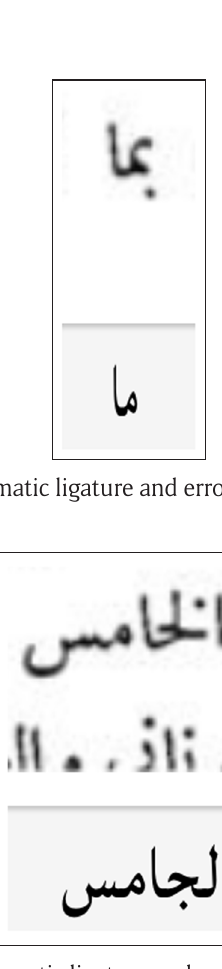
Figure 10: Example of problematic ligature and error in transcription.